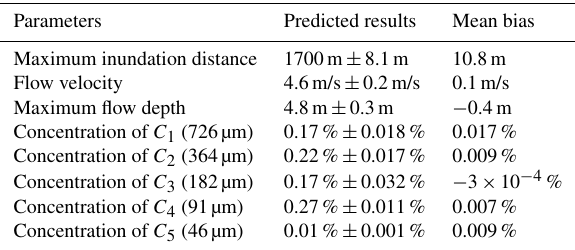
Table 1. Predicted results from the inverse model when applied to the 2004 Indian Ocean tsunami data obtained from the Phra Thong island, Thailand. All reported standard error calculations were per- formed using a 95% confidence